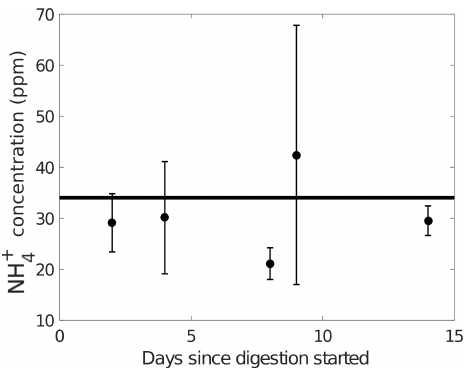
Figure 4. Standard curves from three different days comparing preparations made with KOH solutions to those with only water. Since curves from the same day are indistinguishable with and with- out KOH, the fluorescing reaction is not affected by the presence of KOH (see text for details). Some variability exists between runs, es- pecially at lower concentrations, but variations are small compared to changes in fluorescence units with changing concentration.